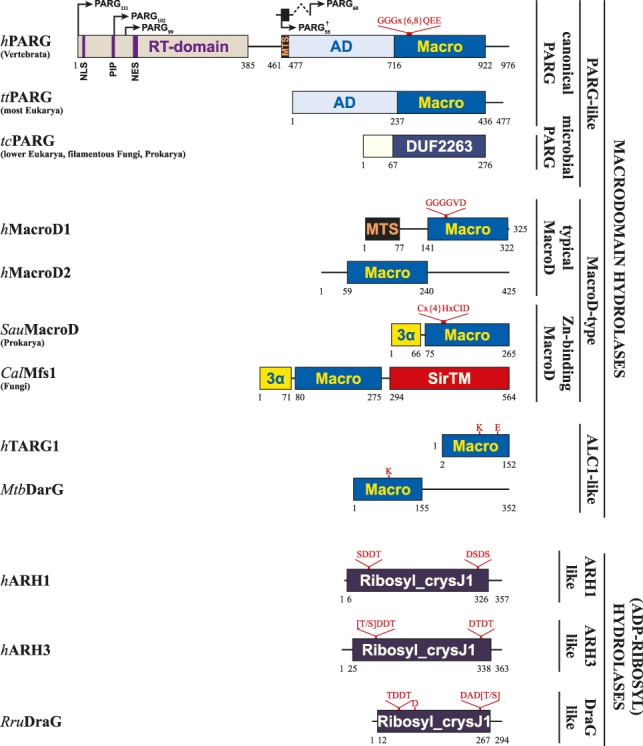
Domain structure of macrodomains and (ADP-ribosyl)hydrolases. The hydrolytic domains are Macro (macrodomain), DUF2263, (microbial PARG), and Ribosyl_crysJ1 (ADP-ribosylation/Crystallin J1 fold), respectively. Subtype-specific sequence motifs are given above the first domain structure (red) of its type. Canonical PARGs contain an accessory domain (AD). In vertebrata, the AD contains a mitochondrial-targeting signal (MTS) and the N terminus is extended by a regulatory and targeting domain (RT domain), which holds the nuclear localization and export signal (NLS and NES, respectively) as well as a PCNA-interacting protein (PIP) box. Other domains: 3α, 3-α-helical bundle; SirTM, sirtuin of M class. Alternative splicing of the single PARG gene in humans is indicated above hPARG. Note that the PARG60 transcript involves splicing of exons 1 and 4 as well as exclusion of exon 5 leading to an altered N-terminal sequence, but including the MTS. The arrow indicates the position from which the primary sequence corresponds to the other splice variants. (†) PARG55 derives from the usage of an alternative start codon in the PARG60 transcript.